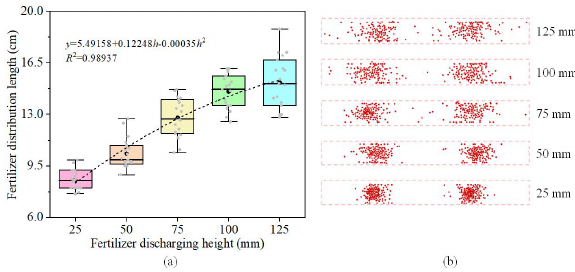
Fig. 6. Variation of the performance of the fertilizer particles with the fertilizer discharging height.